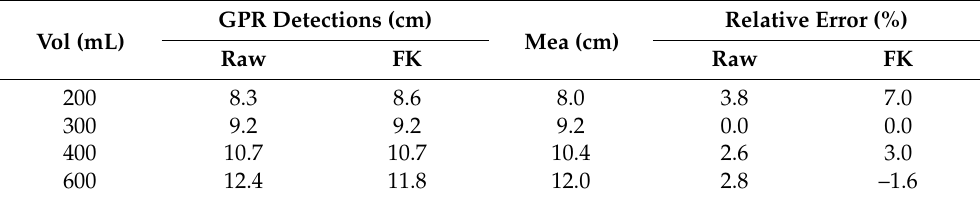
Table 5. GPR detection error for the thickness of the drip irrigation SWB.